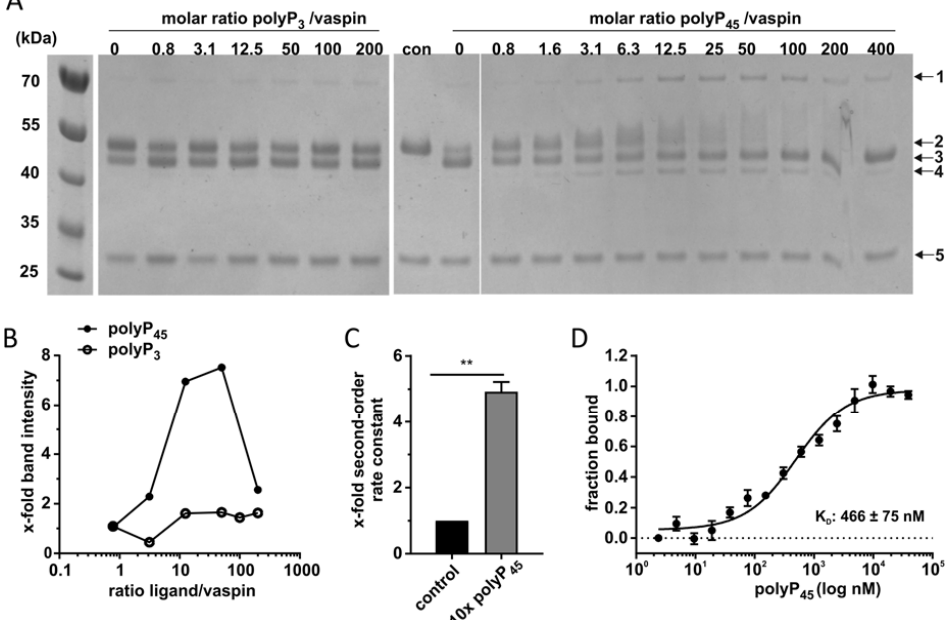
Figure 3. Influence of polyphosphates on complex formation. A ) Shown is complex formation of vaspin with KLK7 (protease/serpin molar ratio 3:1) with increasing concentrations of polyP 3 and vaspin with KLK7 (protease / serpin molar ratio 3:1) with increasing concentrations of polyP 3 and polyP 45 (0.8 − 400 ‐ fold as indicated) after 1 min. Notable and indicated bands are: 1 ‐ vaspin ‐ protease polyP 45 (0.8 − 400-fold as indicated) after 1 min. Notable and indicated bands are: 1-vaspin-protease complex; 2 ‐ full ‐ length vaspin; 3 ‐ N ‐ terminally cleaved vaspin; 4 ‐ RCL ‐ and N ‐ terminally cleaved complex; 2-full-length vaspin; 3- N -terminally cleaved vaspin; 4-RCL- and N -terminally cleaved vaspin; vaspin; 5 ‐ KLK7. B ) Densitometric quantification of complex band intensities in relation to 5-KLK7. ( B ) Densitometric quantification of complex band intensities in relation to ligand / ligand/vaspin ratio of SDS gels. C ) Inhibition of KLK7 by vaspin under pseudo first ‐ order conditions